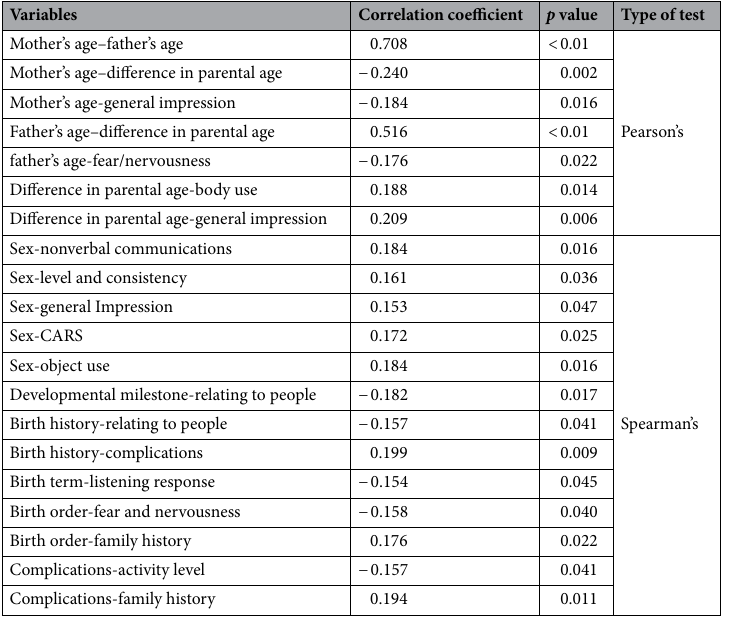
Table 4. Correlation